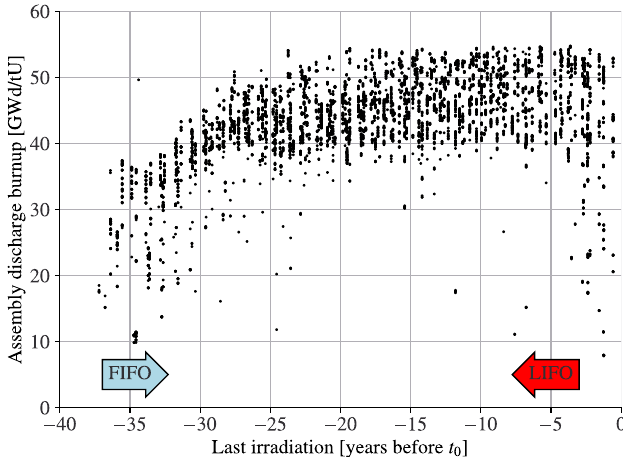
Fig. 6. Fuel assembly discharge burnup for a representative park of nuclear power plants as a function of the time passed between the last irradiation in the reactor core prior to the reference date t 0 .